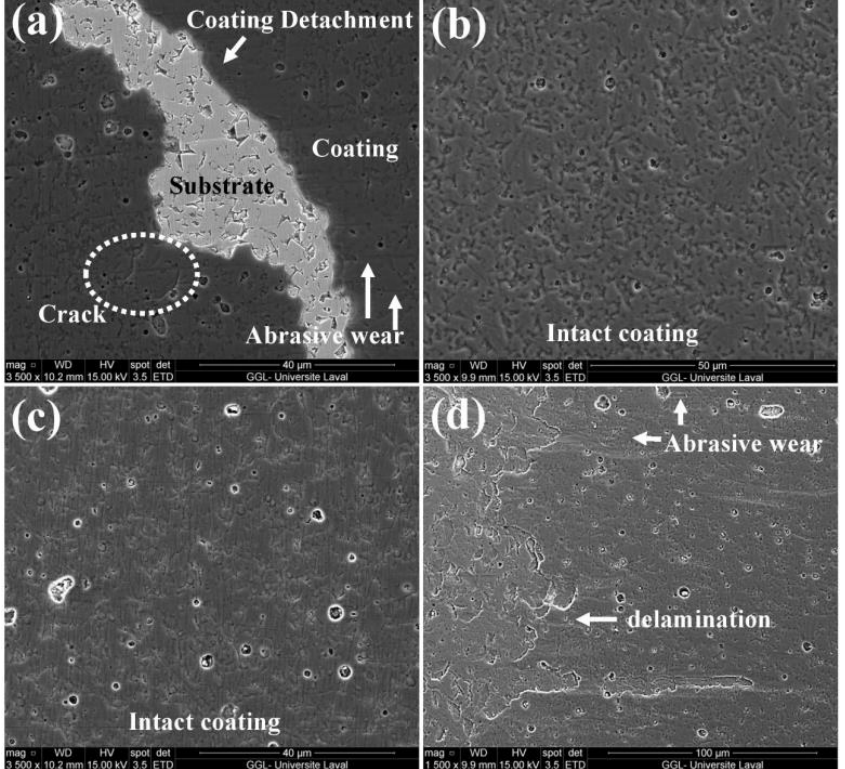
Figure 12. SEM images of wear track on coating ( a ) CrN/CrCN/DLC, ( b ) CrN/AlTiN, ( c ) CrN/CrCN, and ( d ) Crocin/TiSiCN.